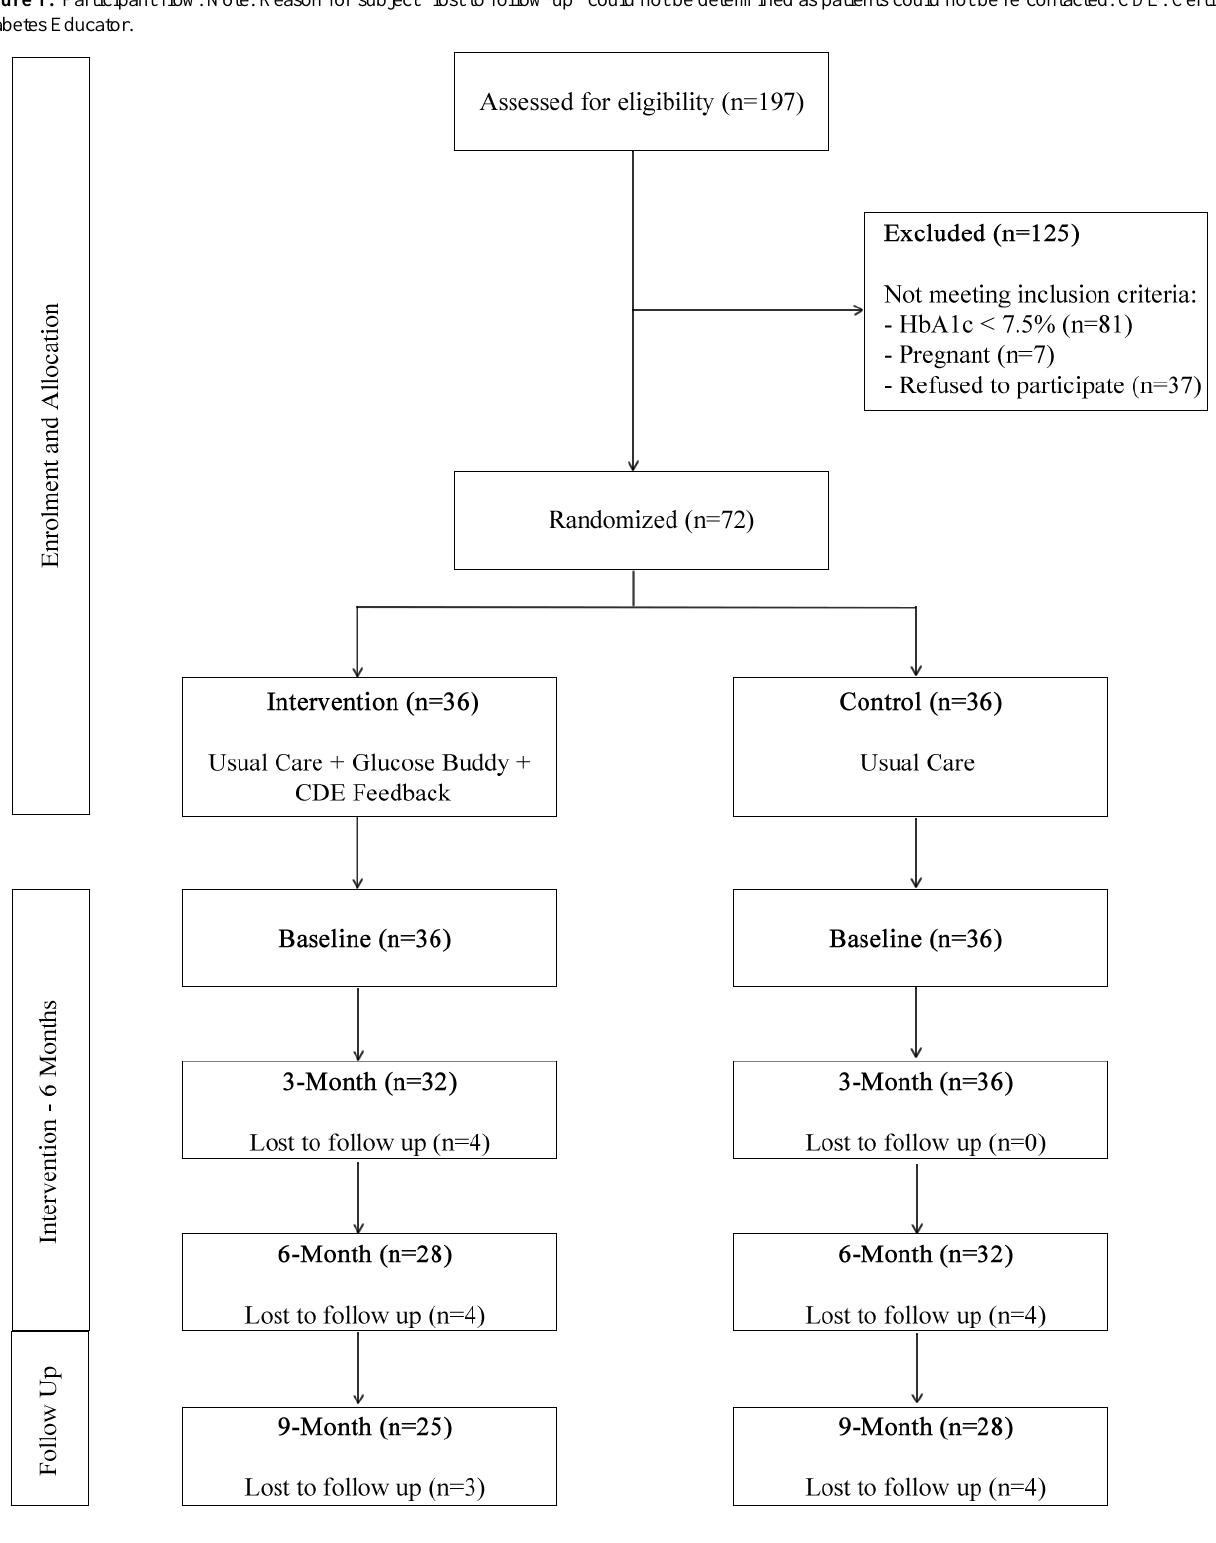
Figure 1. Participant flow. Note: Reason for subject “lost to follow-up” could not be determined as patients could not be re-contacted. CDE: Certified Diabetes